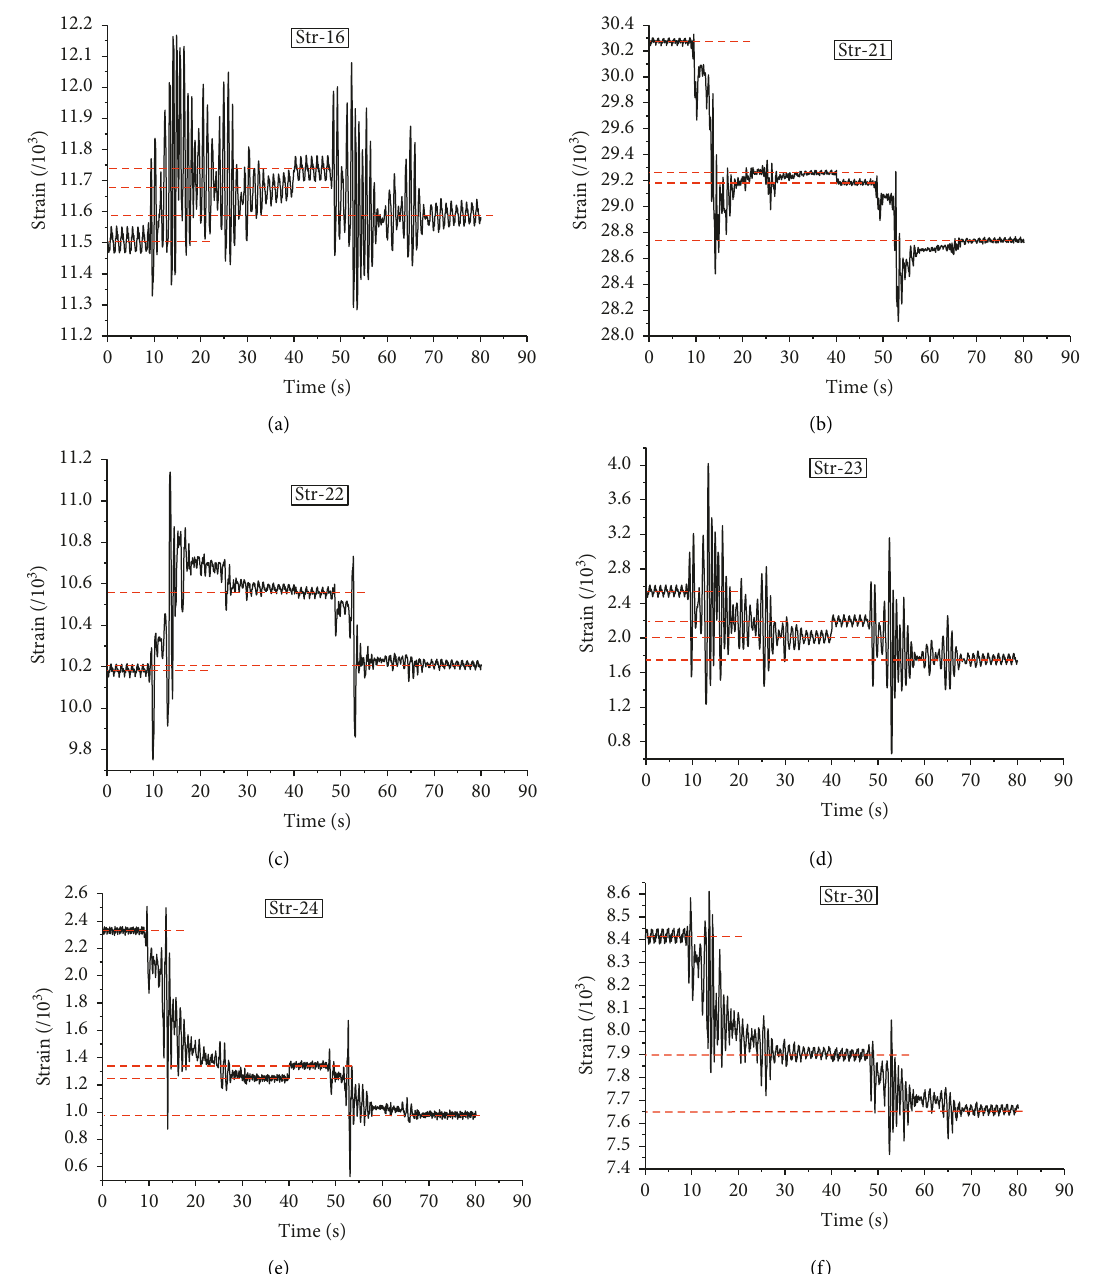
Figure 9: Time histories of strain of PVC pipe under seismic